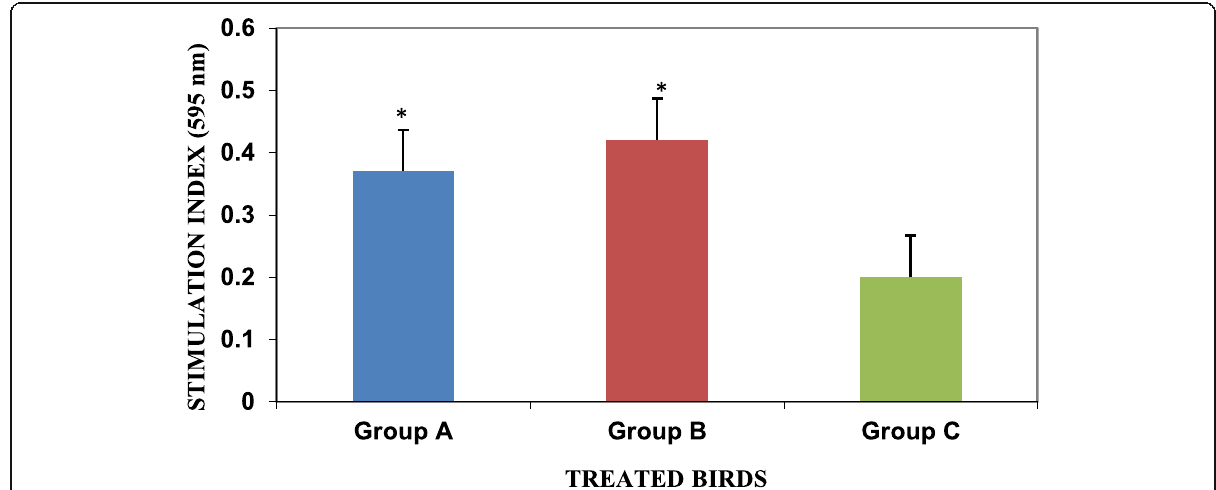
Fig. 4 In vitro lymphoproliferation assay of PBMC of MG-fed and control broiler birds after challenge with RD virus